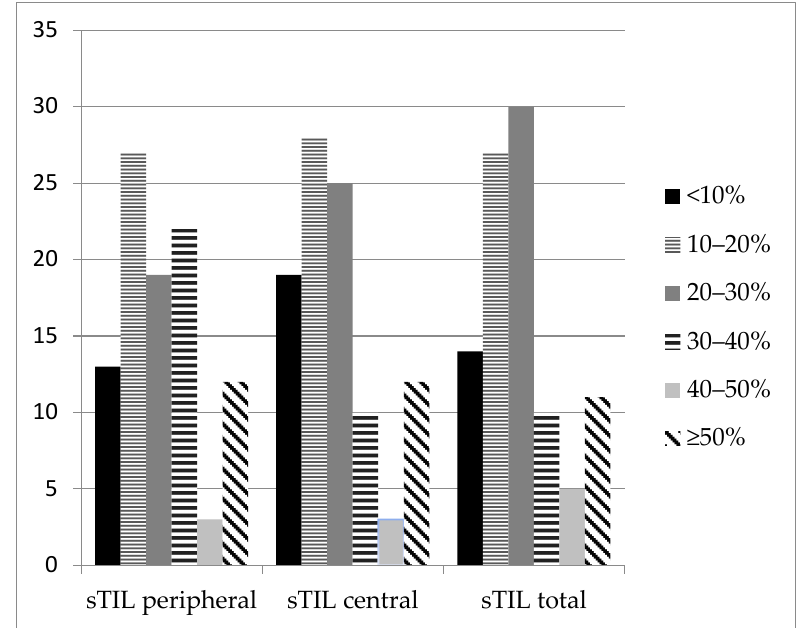
Figure 3. Distribution of peripheral sTILs, central sTILs, and total sTILs in TNBC ( n = 97). The total accumulation of stromal TILs (sTILs) was scored as a percentage (%) of the occupied stromal component at the infiltrative margin and in the center of the tumor (sTIL total). Additionally, the accumulation of stromal TILs was evaluated separately in the center of the tumor (sTIL central) and at the periphery at the invasive front of the tumor (sTIL peripheral).